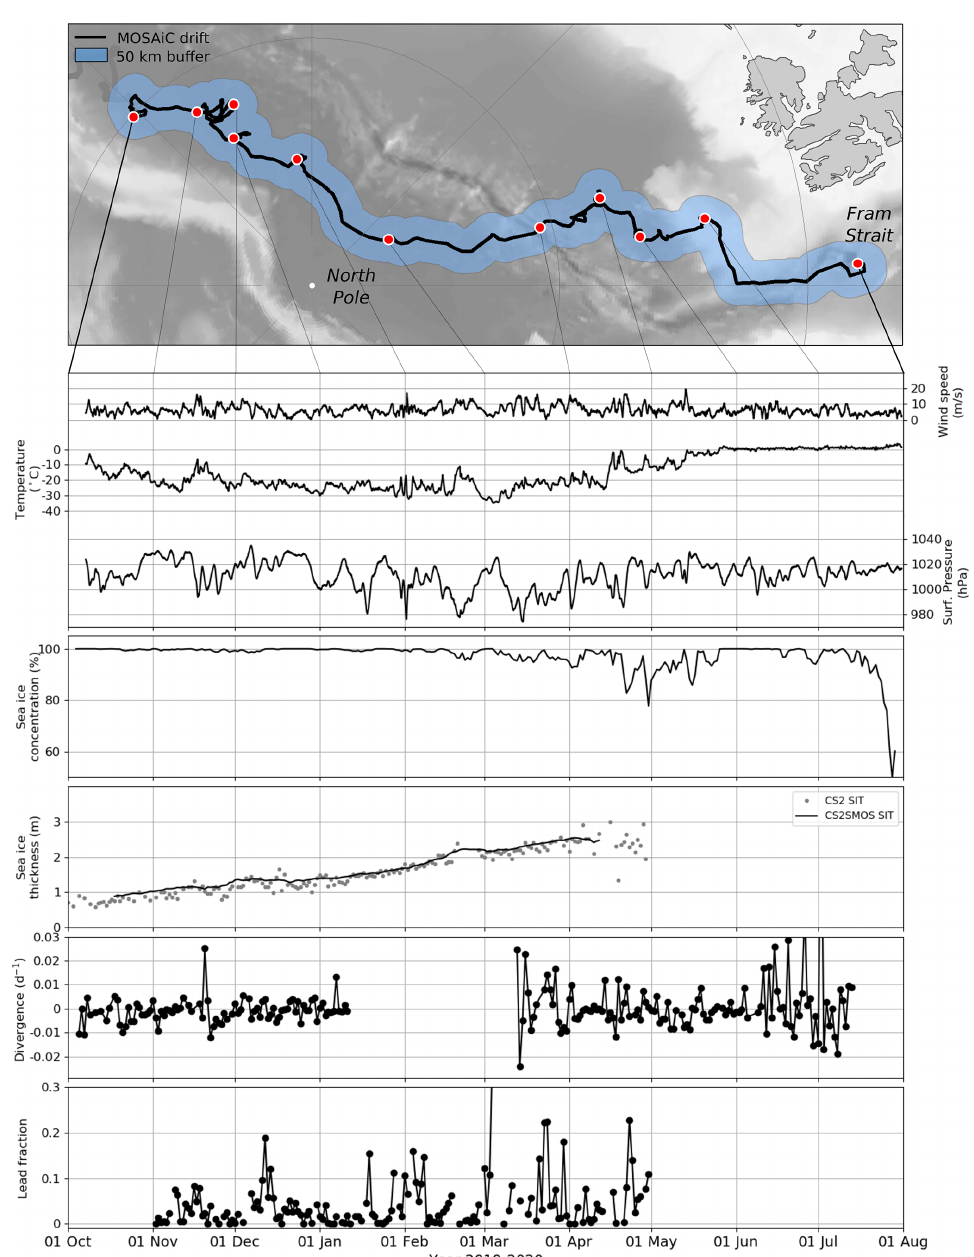
Figure 19. Summary of the atmospheric and ice conditions extracted from reanalysis and satellite data within a 50km radius (top) along the MOSAiC CO drift track. Note that the drop in sea ice concentration in April–May is apparent only due to wet snow (see Sect.